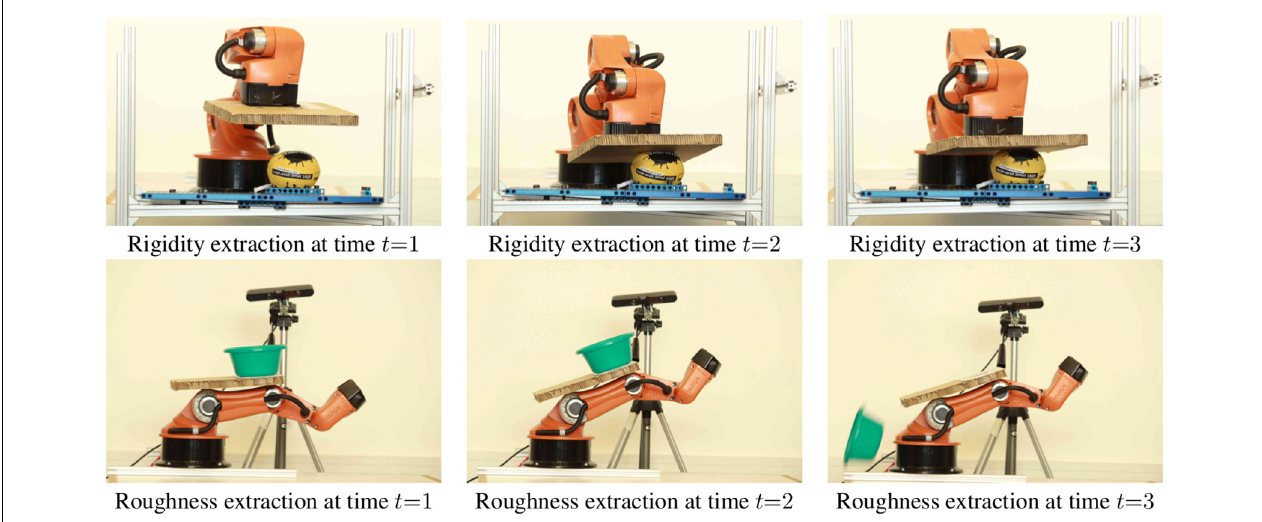
FIGURE 5 | Light-weight experimental setup consisting of a camera-manipulator combination, for acquiring physical property rigidity (top row) and roughness (bottom